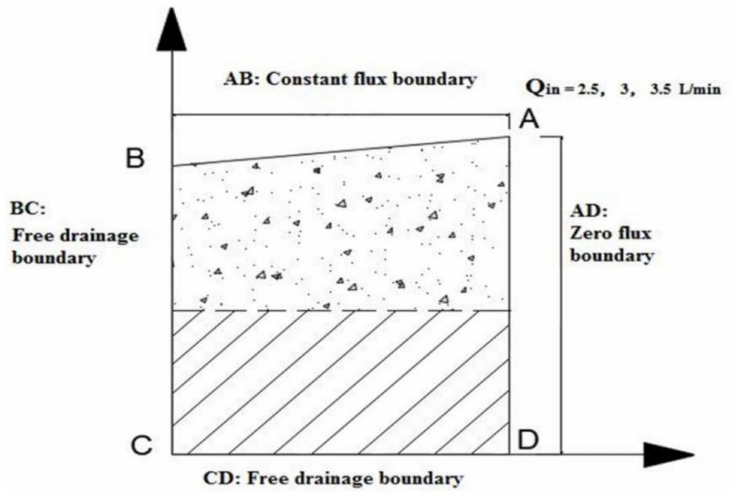
Figure 4. Conceptual model of